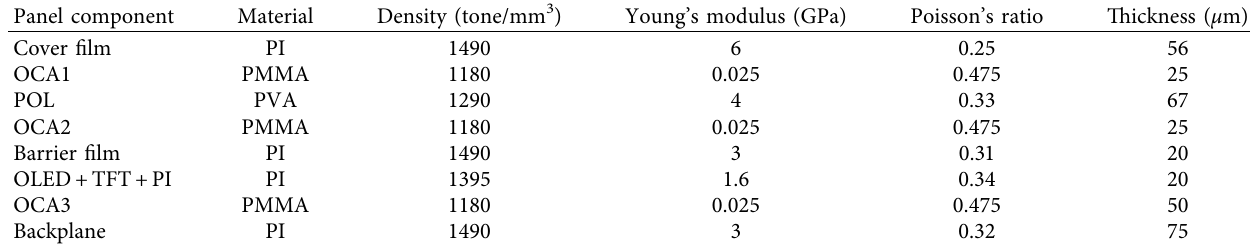
Table 1: Material data for each layer of the